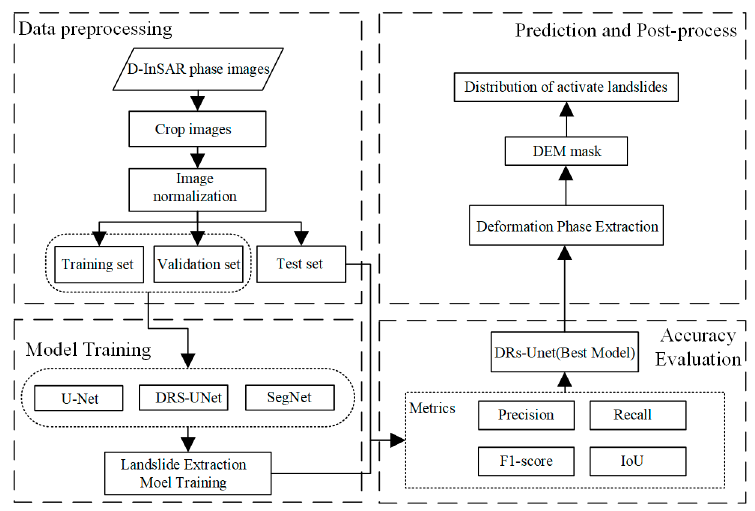
Figure 5. Flowchart of automatic extraction of active landslides from InSAR imagery.